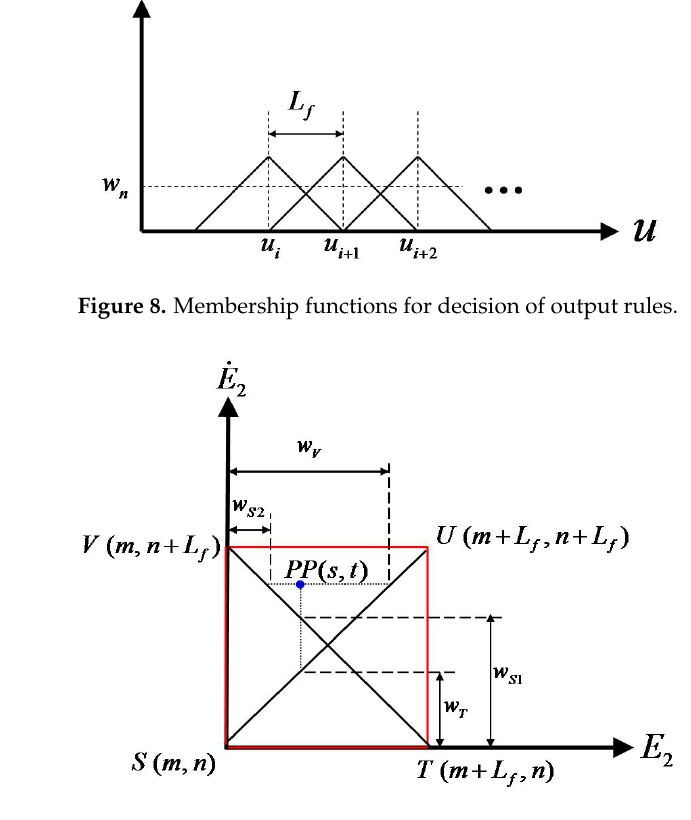
Figure 9. Rectangular grid of the fuzzification plane. Table 1. Rule base for fuzzy compensator.